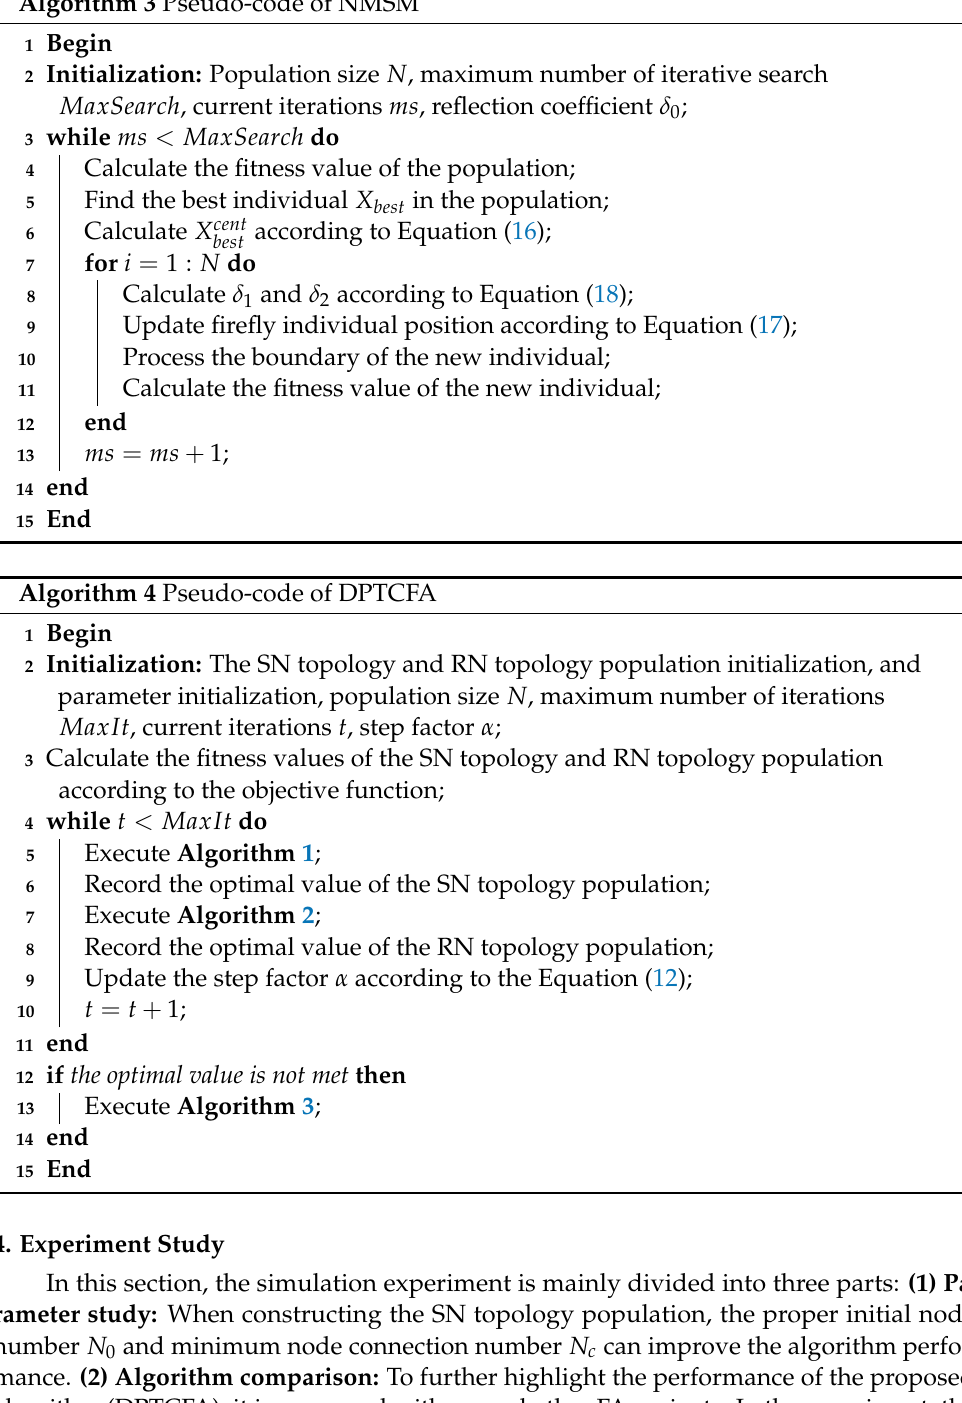
Algorithm 3 Pseudo-code of NMSM